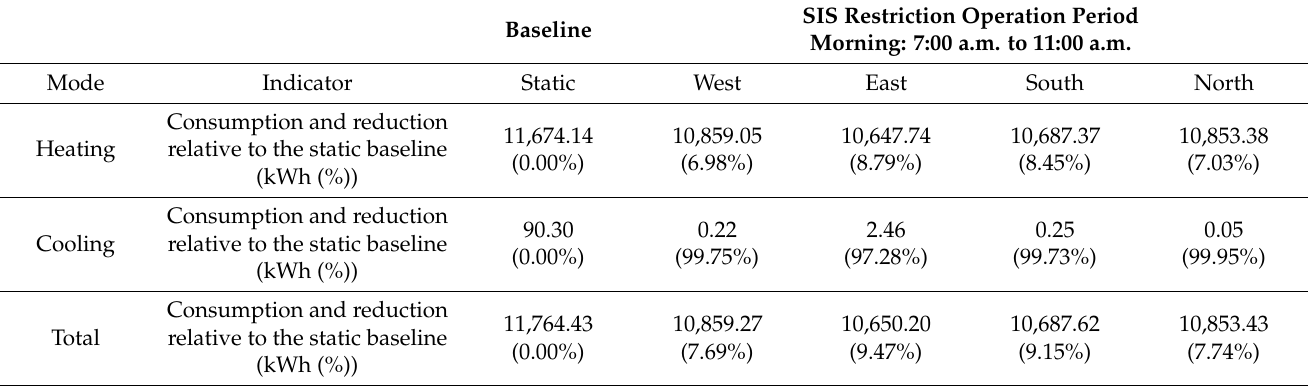
Table 12. Comparison of annual space heating and cooling energy consumption when a single window of the prototypical detached house model is forced open during the morning.